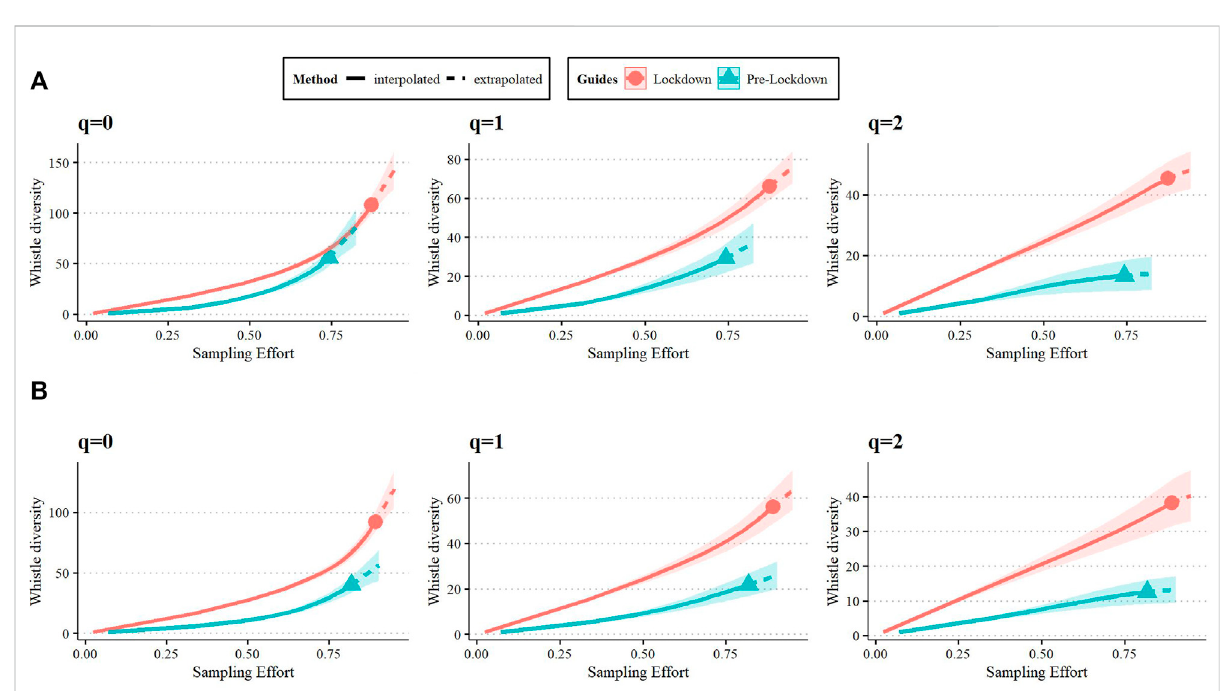
Frontiers in Remote